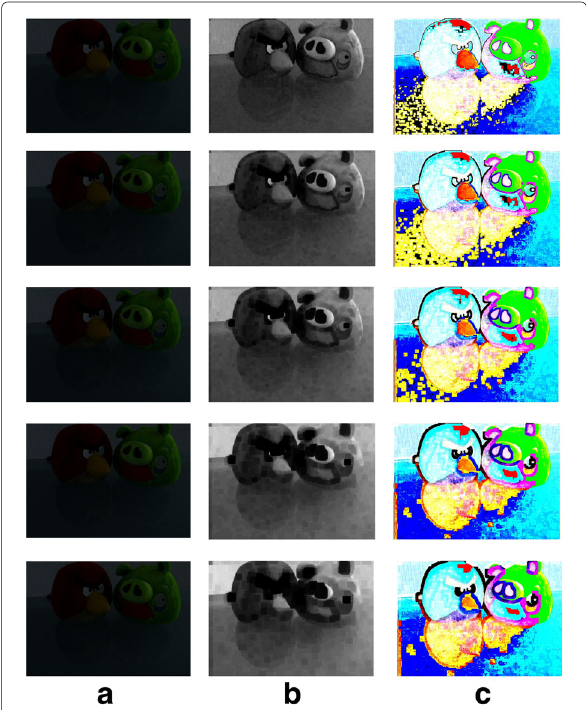
Fig. 16 The influence of a local patch size on the recovered image quality. From top to bottom, the local patch sizes are 5 × 5, 10 × 10, 15 × 15, 20 × 20, and 25 × 25. a Input image. b Transmission